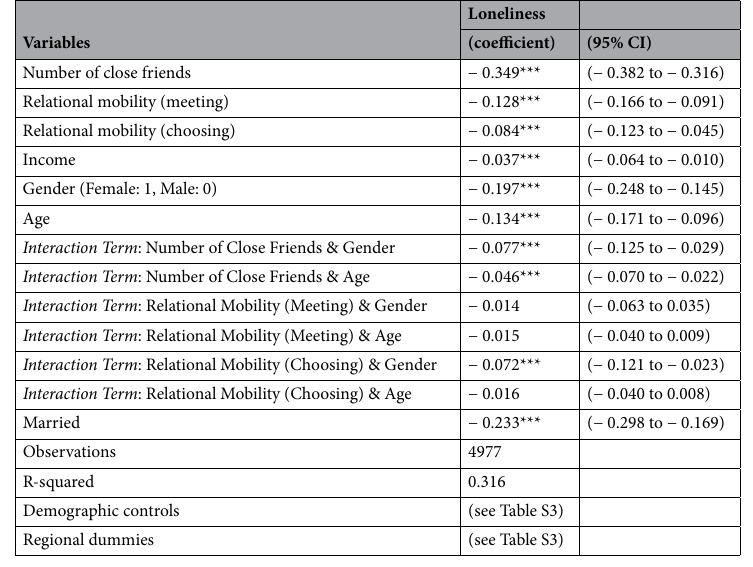
Table 3. Abbreviated OLS regression of factors underlying loneliness in Japanese general population sample, with moderator variables of gender and age. *p < 0.10; **p < 0.05; ***p < 0.01. Regression coefficients for factors underlying loneliness, with standardized regressors. Negative coefficients correspond to lower loneliness. 95% confidence intervals (95% CIs) are given in parentheses. Only coefficients for the most relevant independent variables are shown, for the full regression table see Supplementary Table S3.